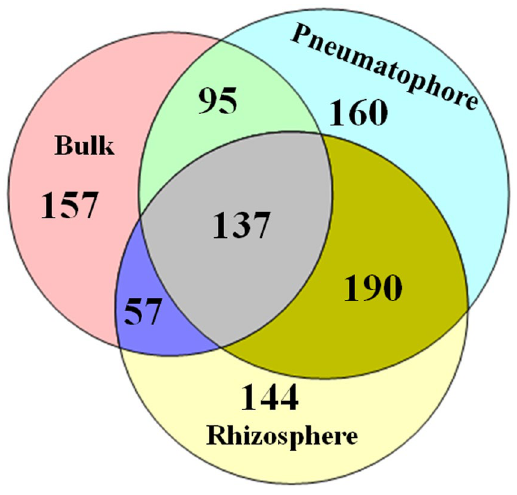
Figure 6. Venn diagram showing the number of shared and unique fungal OTUs (ITS region) in bulk, rhizosphere and pneumatophore compartments. OTUs were clustered at 97% similarity level. Venn diagrams were generated in Mothur v.1.35.0 and modified using Venn diagram plotter software.